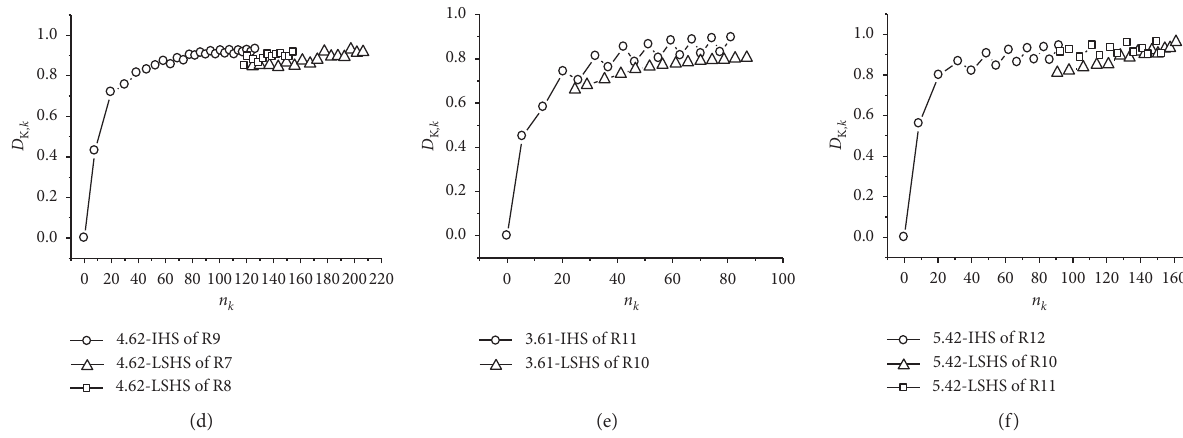
Figure 10: D E k - n k relations for specimens R4 to R6, R7 to R9, and R10 to R12 according to the principle of the same normalized effective amplitude.